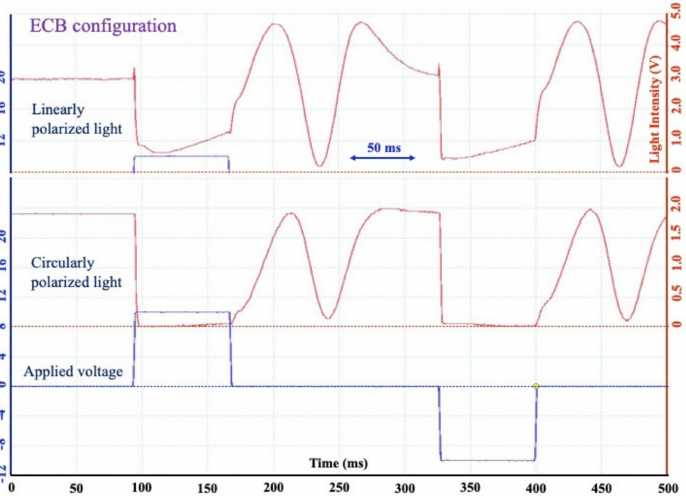
Figure 3. Light-throughput dynamics of an Electrically Controlled Birefringence-Liquid Crystal (ECB-LC) panel to both linearly polarized and circularly polarized incident light, respectively.